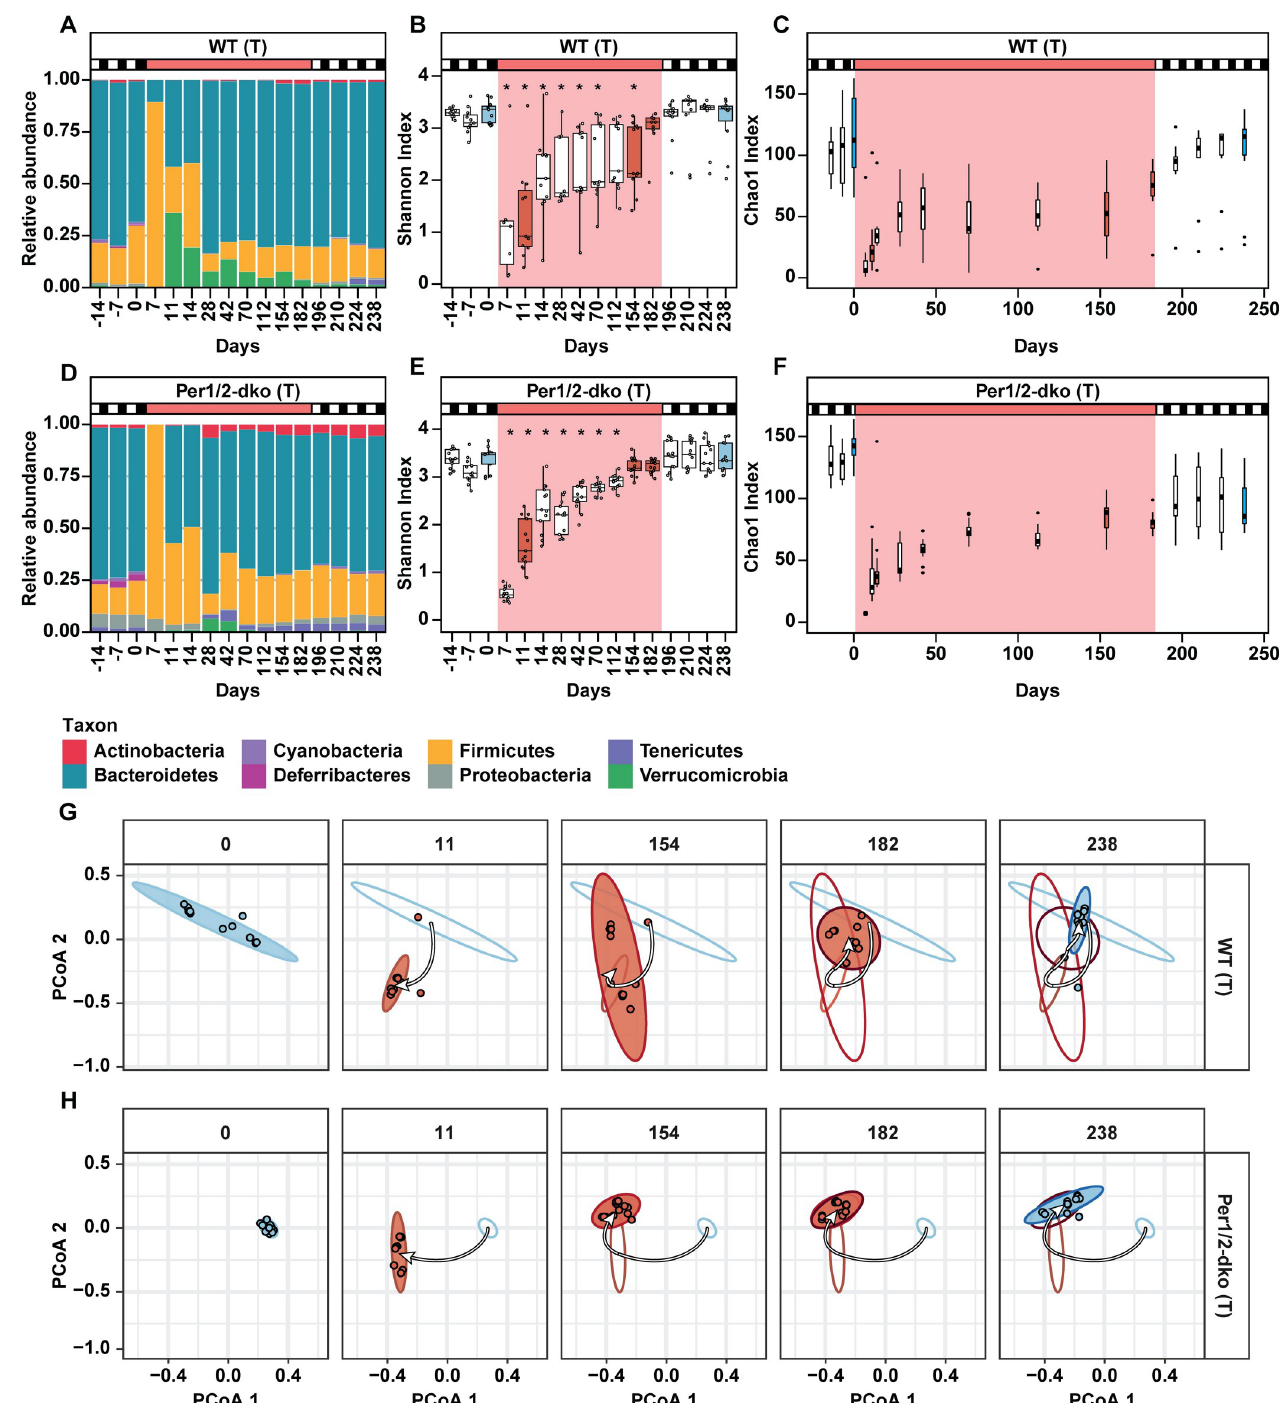
Fig 3. Alpha- and beta-diversity characterizations of the responses of gut microbiome to rhythmic vs. non-rhythmic host behaviors after brief perturbation from antibiotics. Sample groups are labeled as in Fig 1A: WT(T) and Per(T) for the groups treated with antibiotics on Days 0–5 (transferred from LD to RR on Day 0, and back to LD on Day 182). Data are plotted as in Fig 2. The data used to compile this figure are included in S1 Data File. (A and D) Quantification of the average relative abundances of the microbiota at the phylum level based on 16S sequences at various time points during the regimen in the 4 groups. The upper abscissae for panels A–F indicate LD conditions (black/white boxes) and RR (red). (B and E) Shannon index analyses of alpha-diversity of the microbiota at various time points during the regimen in the 4 groups, plotted as in Fig 2. (C and F) Chao1 diversity analyses of alpha-diversity of the microbiota, plotted as in Fig 2. (G and H) Beta-diversity analyses for WT(T) and Per(T) samples, plotted as in Fig 2. White arrows indicate the trajectory of the